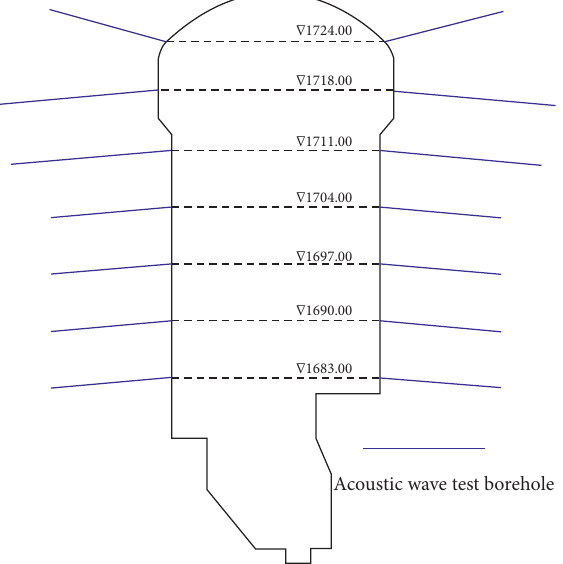
Figure 11: A typical layout of acoustic velocity test boreholes around a section of the main powerhouse of Houziyan